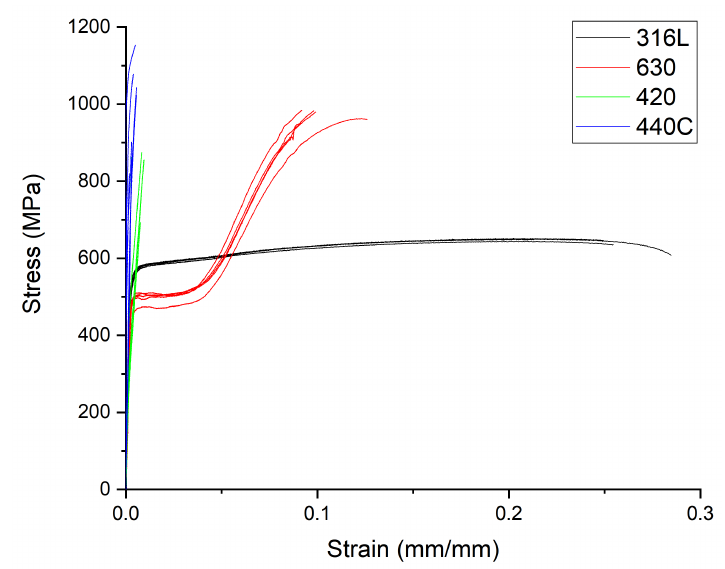
Figure 10. Strain–stress curves for the 316L (black), 630 (red), 420 (green) and 440C (blue) steels.